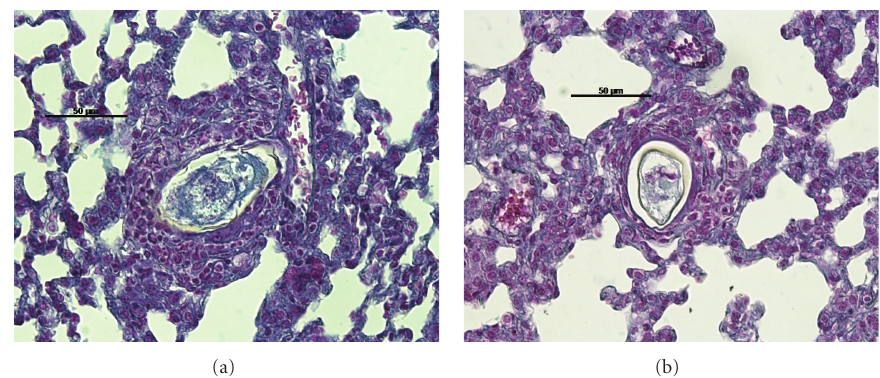
Figure 1: Formation of a halo cell around mature (a) S. mansoni BH (Group I) and (b) SJ (Group II) eggs in the pulmonary parenchyma one day after inoculation of the eggs in the caudal vein of